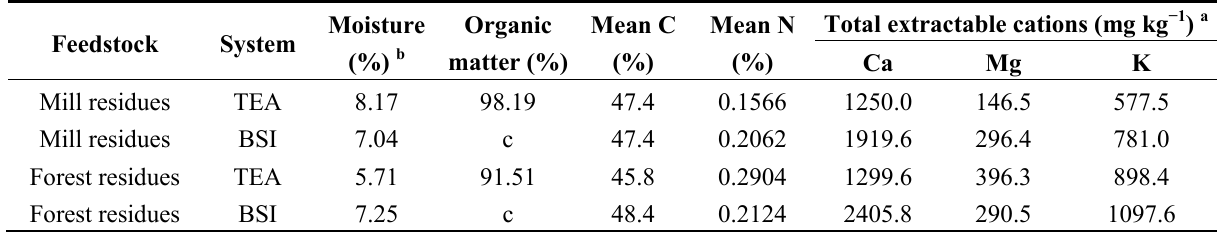
Table 1. Feedstock characteristics.